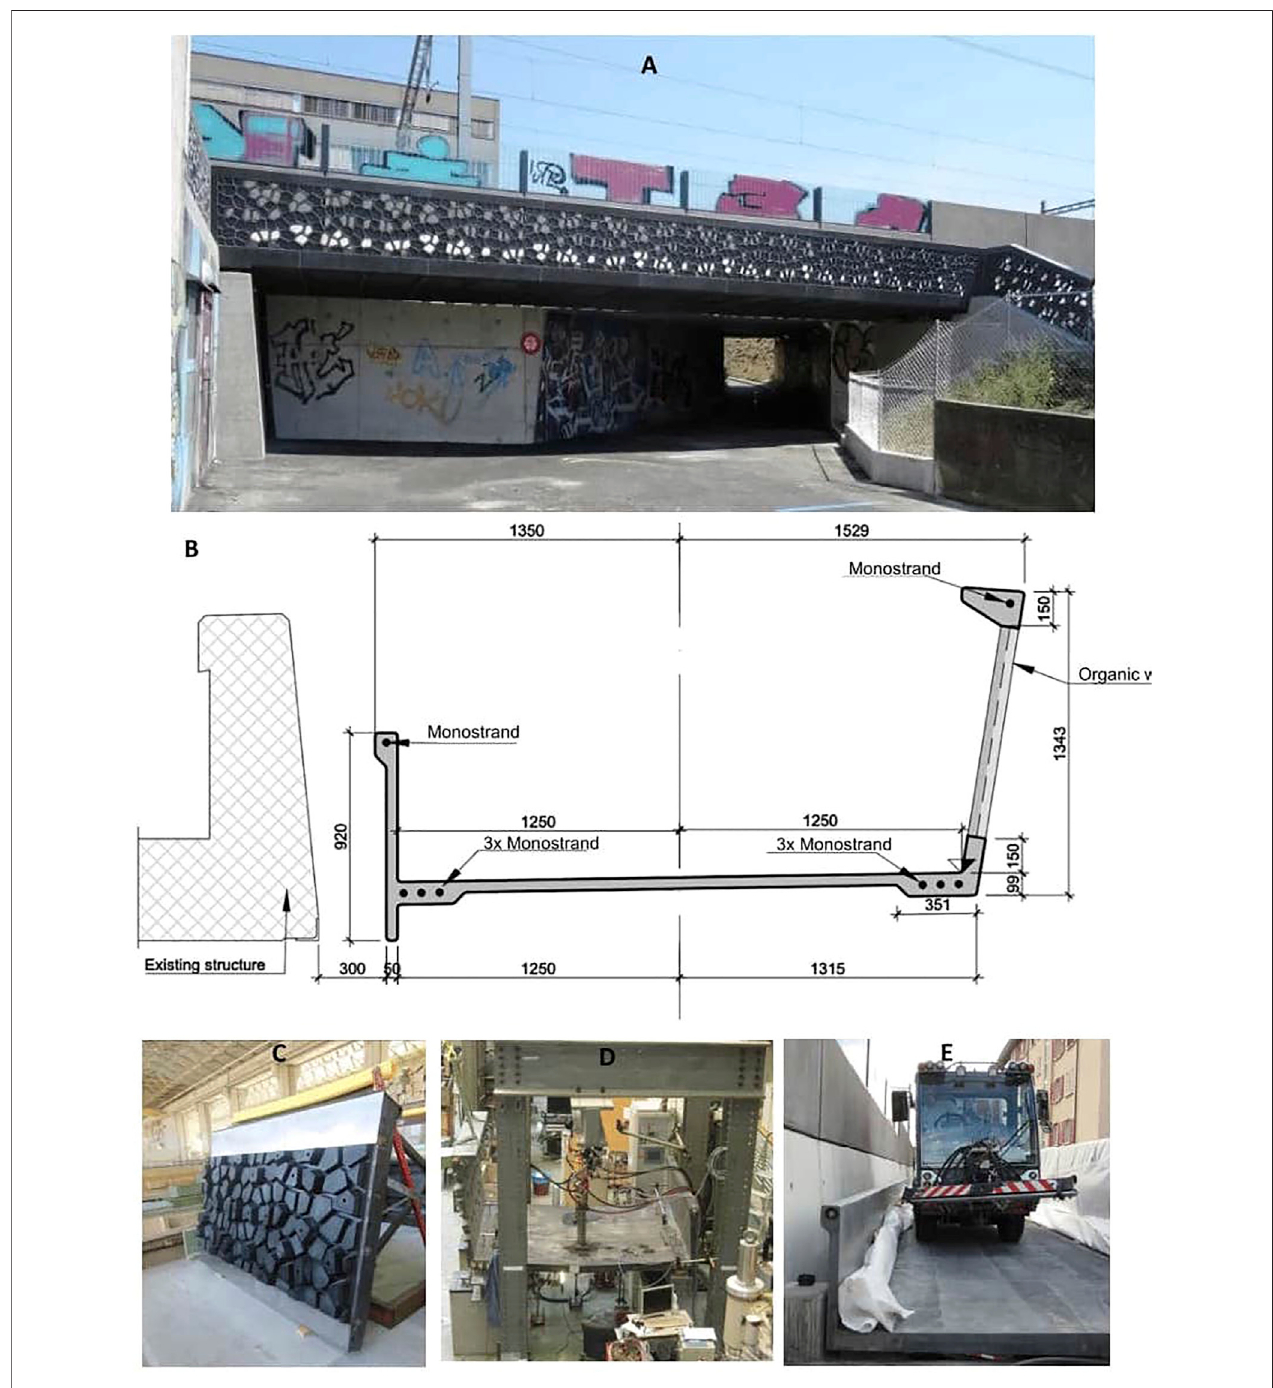
FIGURE 11 | Martinet footbridge. (A) Photograph of the footbridge; (B) Drawing of section. (C) Mold for the organic web of the Martinet footbridge; (D) laboratory test on the deck; (E) in-situ load test. (Photographs: E. Brühwiler).